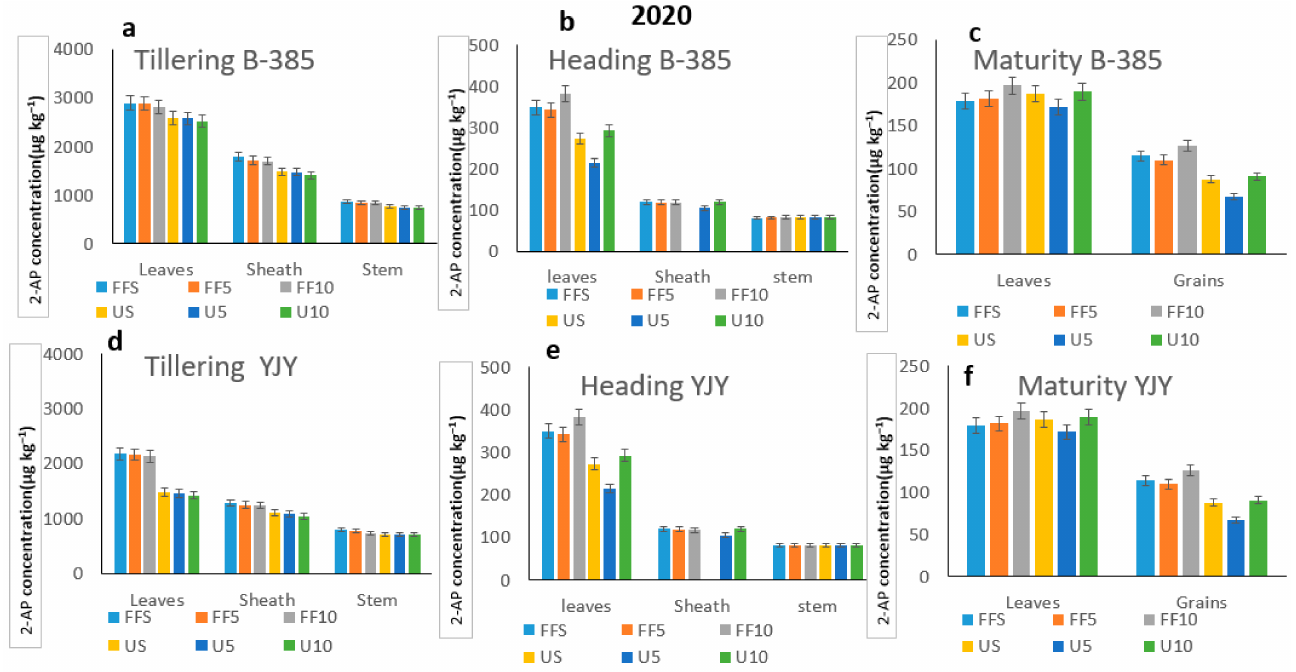
Figure 4. AP contents ( µ g kg − 1 ) of different cultivars under fertilizer application in 2020: ( a ) AP